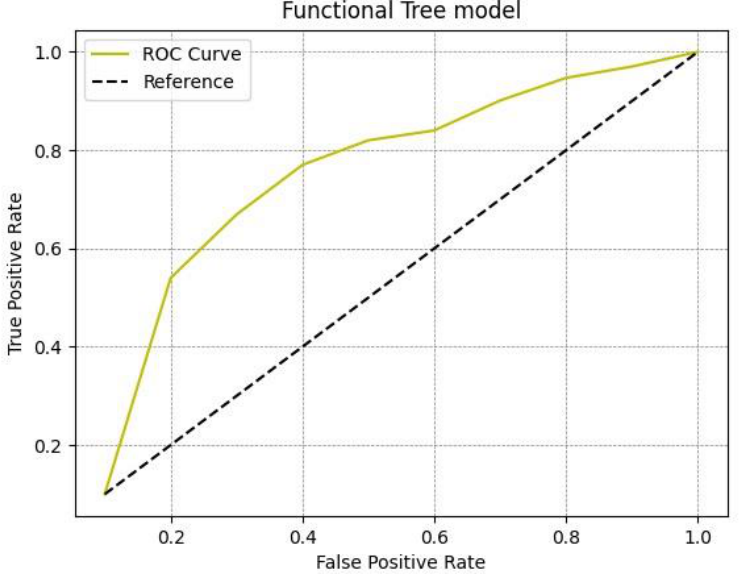
Figure 2. ROC curve for the functional tree Figure 2. — ROC curve for the functional tree model.